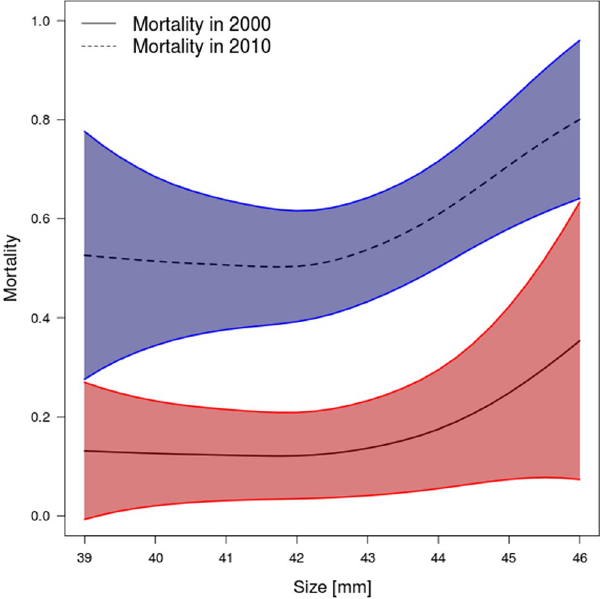
Figure 3. Mortality increase with forearm length (for environmental conditions fixed at year = 2000 and 2010) as estimated from Model 6, 95% confidence intervals